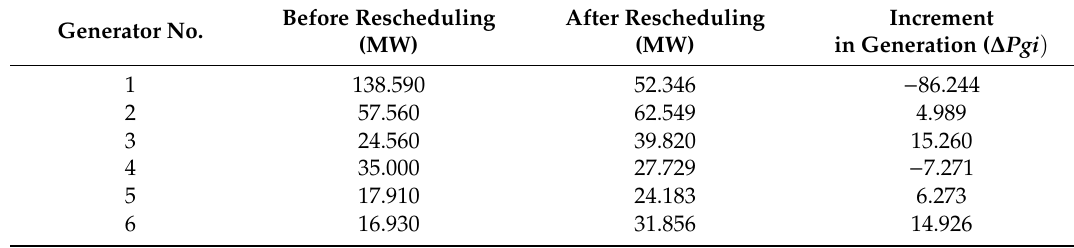
Table 9. Rescheduling with Table 8. Sensitivity factor without PHSU.